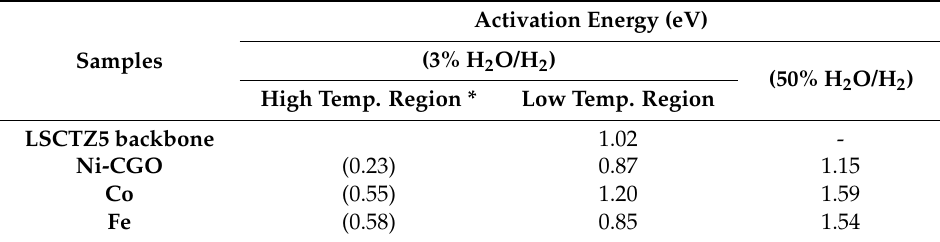
Figure 6. Arrhenius plots of polarization resistance as a function of temperature and atmosphere. Table 4. Activation energies of the LSCTZ5 backbone and infiltrated